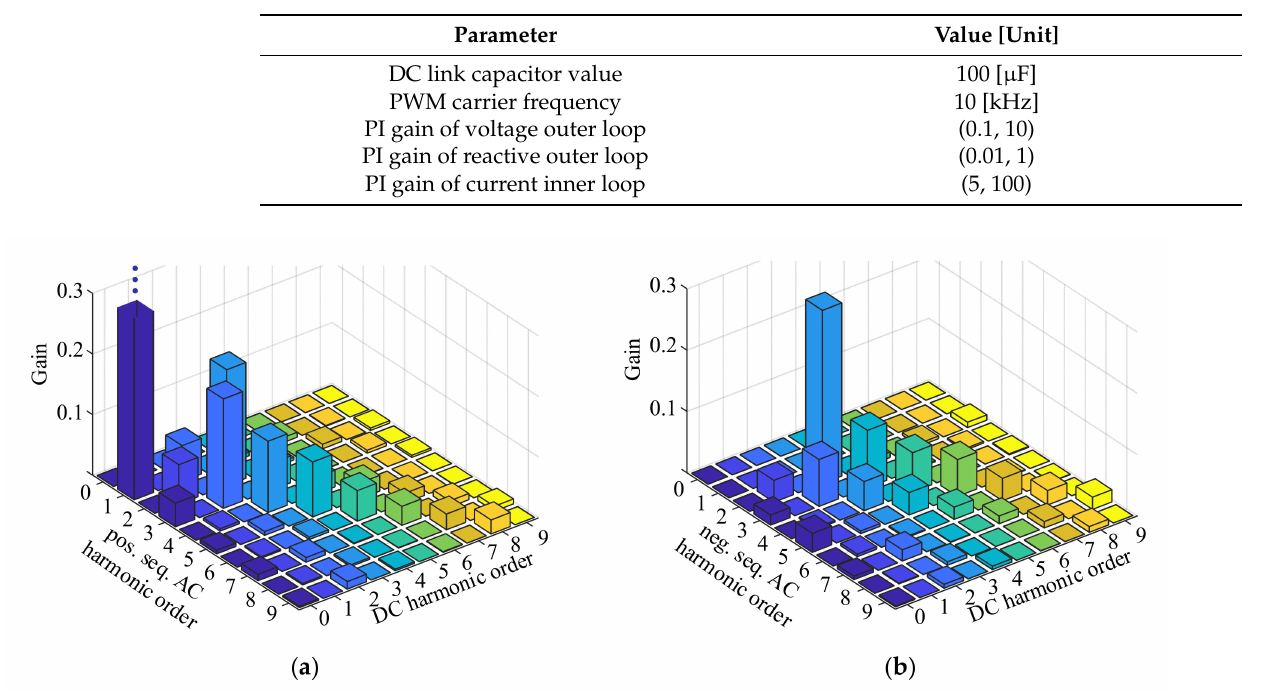
Figure 5. AC-DC Harmonic Coupling Gains of the Three-Phase VSC. ( a ) Coupling Gains between Positive-Sequence and DC Current Harmonics, ( b ) Coupling Gains between Positive-Sequence and DC Current